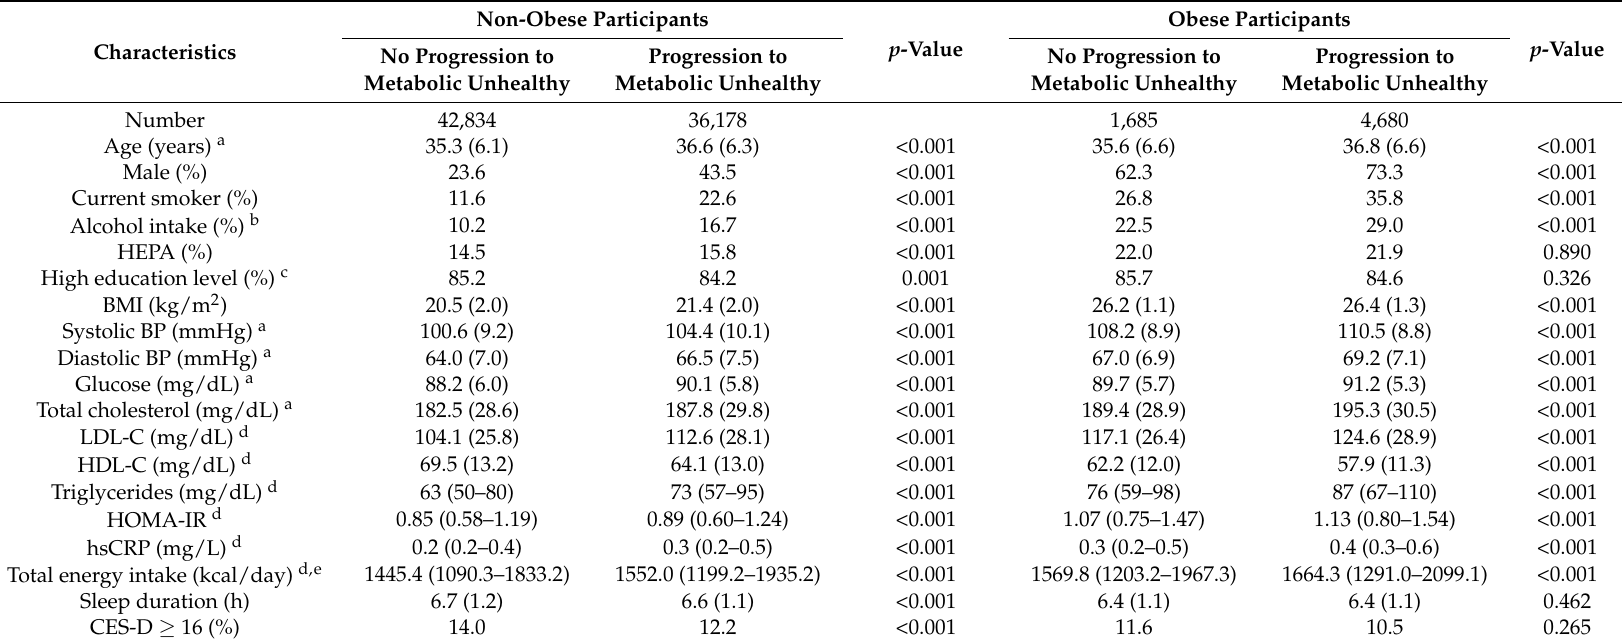
Table 1. Baseline characteristics of study participants according to progression to metabolic unhealthy status by